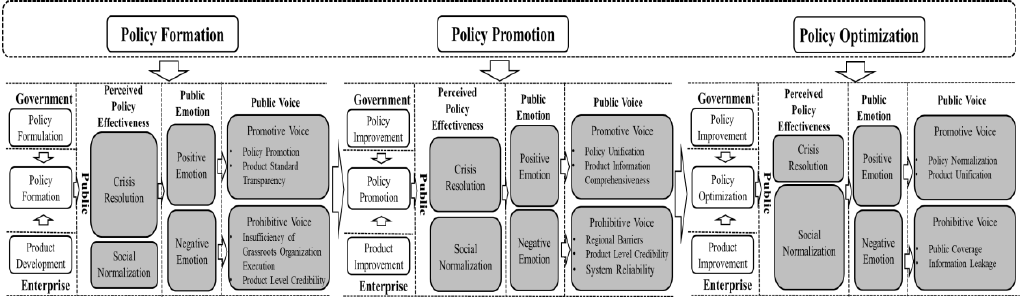
Figure 2. Model of the dynamic e ff ect of public voice behavior on policy, results of grounded theory are shaded grey.